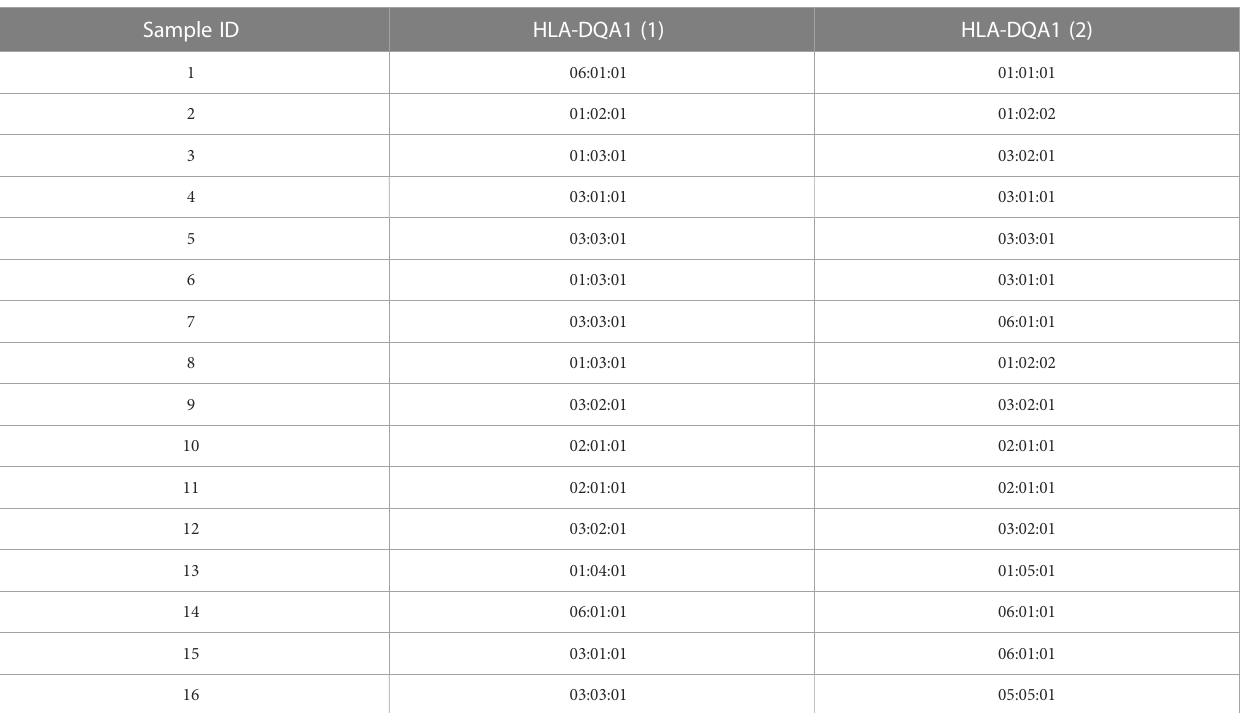
TABLE 2 HLA-DQA1 typing